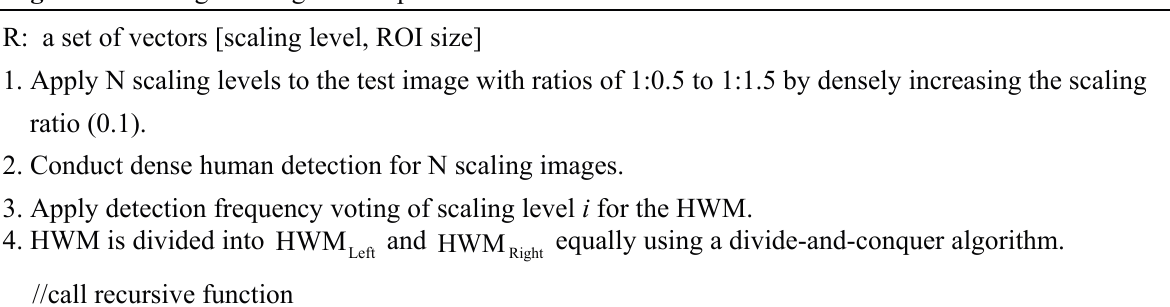
Algorithm 1 Image scaling and adaptive